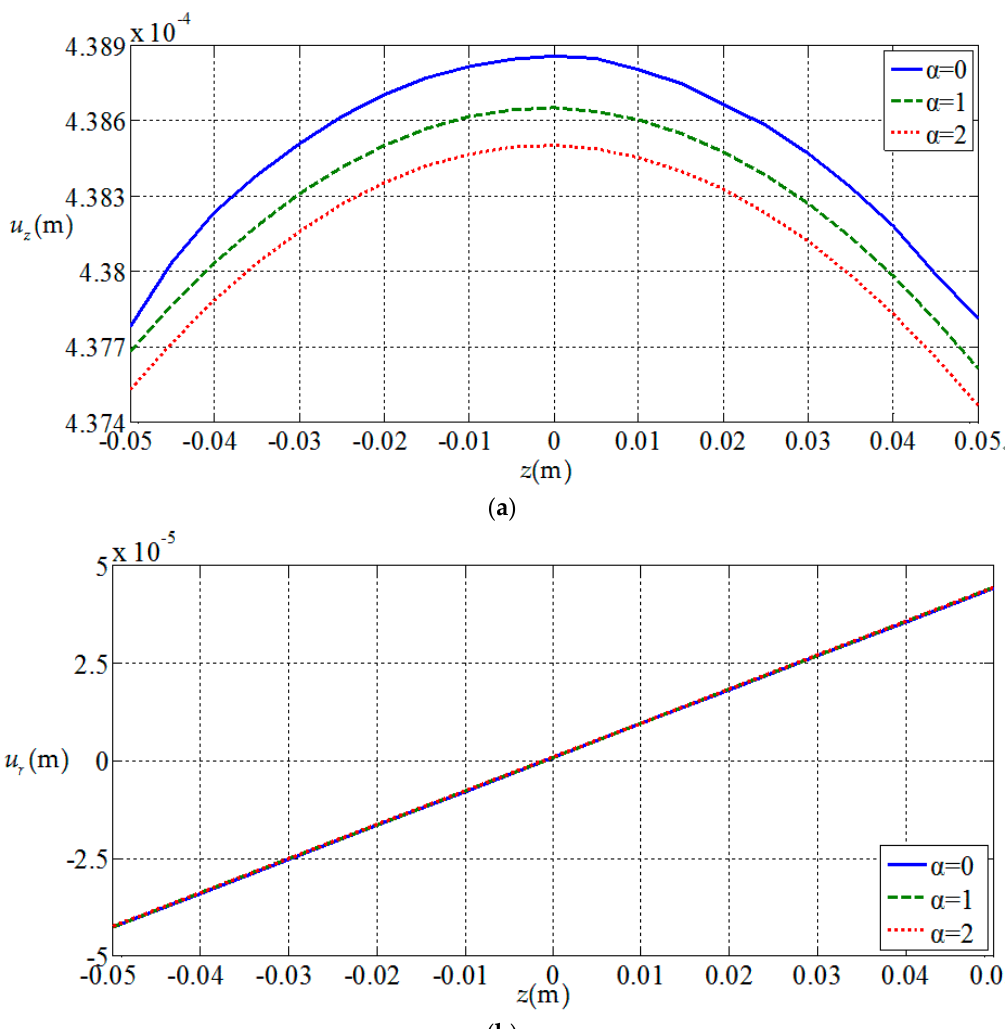
Figure 6. Variation of elastic displacements with coordinates z . ( a ) z -direction displacement at the center of plate u z ( 0, z ) ; ( b ) radial displacement at the periphery of plate u r ( 1, z )